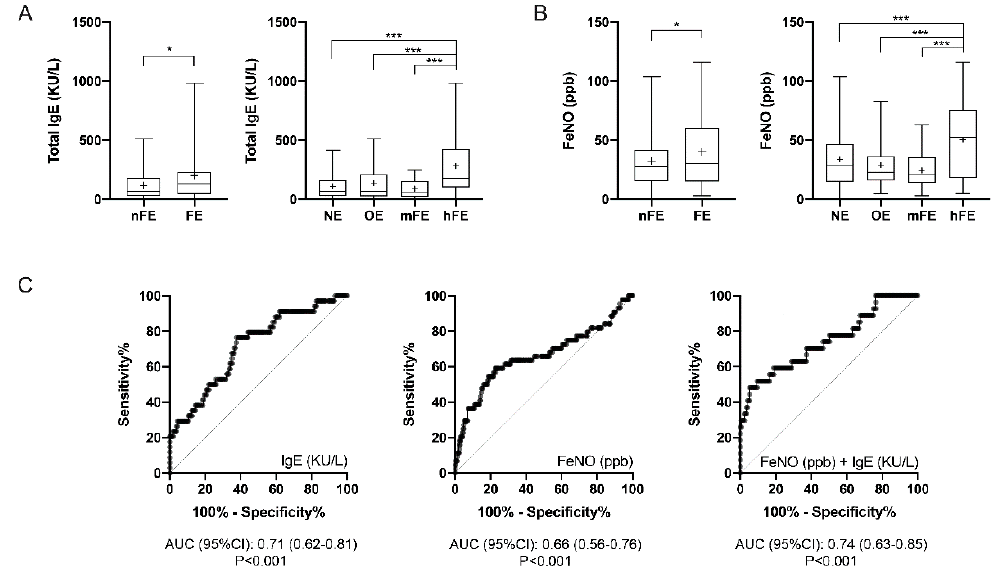
Figure 3. T2 biomarkers in the asthmatic population after stratification according to the number of exacerbations: ( A ) serum IgE concentrations, ( B ) FeNO values, and ( C ) their respective and cumulative ROC curve analyses. Box plots represent data from the first to the third quartile; whiskers represent the minimum and maximum values; “ + ” indicates the mean value. * p < 0.05; *** p < 0.001.